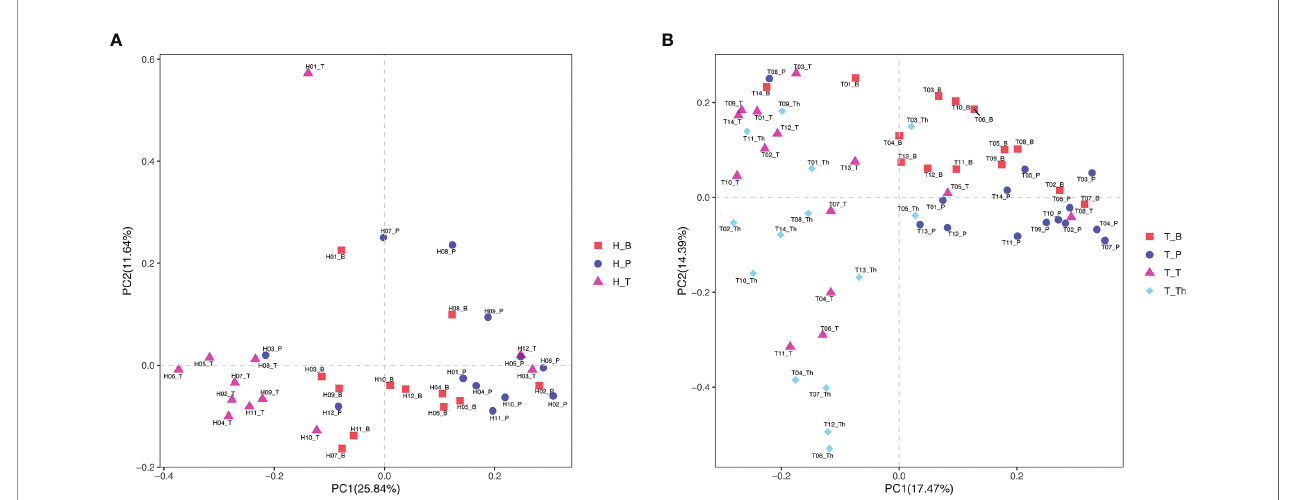
FIGURE 4 | Principal coordinates analysis (PCoA) plot of microbiota community structure across different niches within tonsil healthy participants and tonsillar hypertrophy patients. (A) Microbiota community structure distribution in tonsil healthy participants. (B) Microbiota community structure distribution in tonsillar hypertrophy